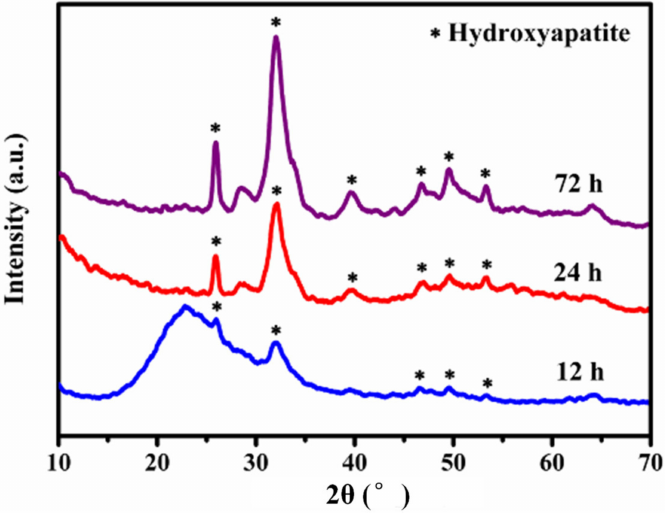
Figure 7. XRD patterns of MBG scaffold after immersion in SBF for different